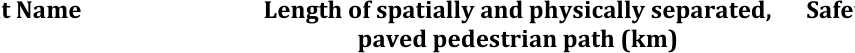
Table 5: Values of safety indicator (S)